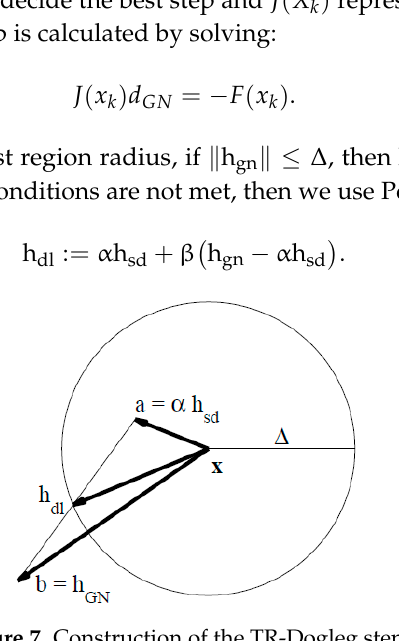
Figure 7. Construction of the TR-Dogleg step.